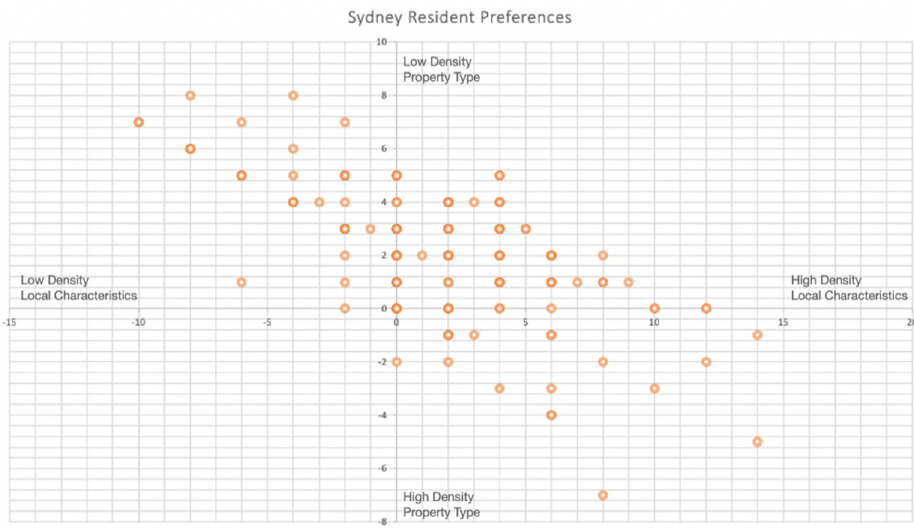
Figure 3. Sydney Resident Preferences.